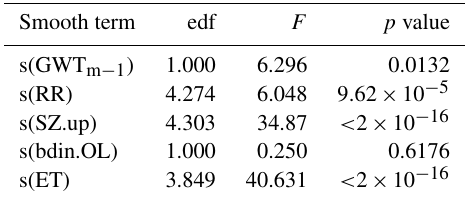
GWT m − 1 : monthly mean groundwater table depth in the preceding month; RR: monthly mean precipitation; SZ.up: monthly mean upward saturated flow from the lower computational layer; bdin.OL: monthly mean overland boundary inflow; ET: monthly mean actual